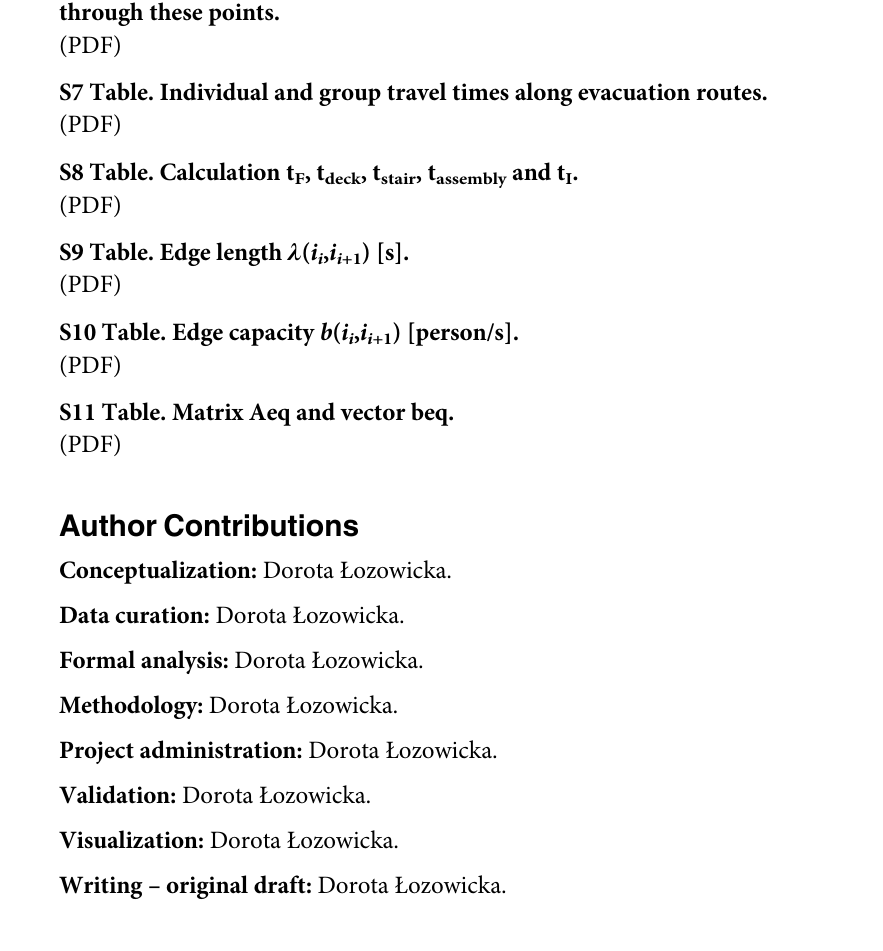
S1 Table. Dimensions of escape routes leading to DP1. S2 Table. Dimensions of escape routes leading to DP2. S3 Table. Dimensions of escape routes leading to DP3. S4 Table. Dimensions of escape routes leading to DP3. S5 Table. The values of occupant distribution and initial density D at the start of evacua- tion and the values of initial specific flow Fs and speed S and calculated flow Fc. S6 Table. Calculation of the transition points of the escape routes and the flow Fc and S through these points. S7 Table. Individual and group travel times along evacuation routes. (PDF) S8 Table. Calculation t , t , t , t and t . F deck stair assembly I (PDF)